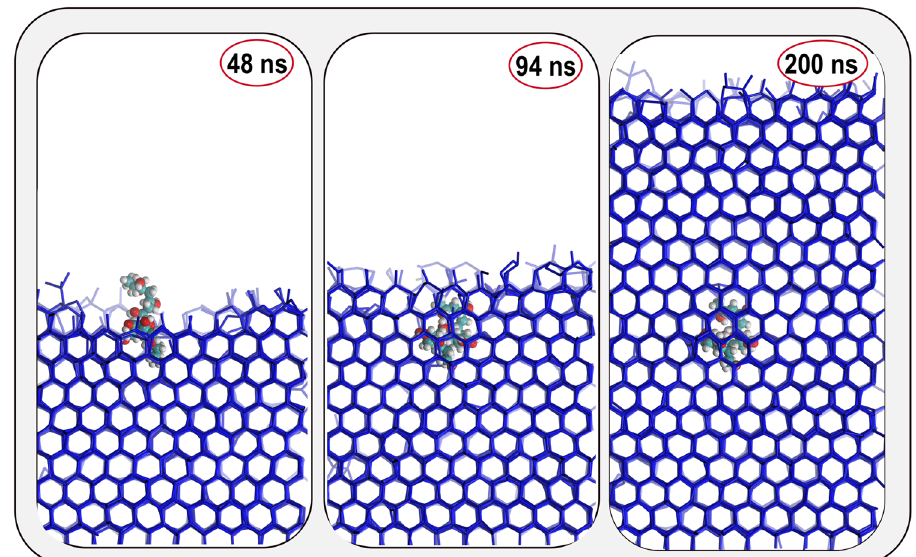
Fig. 4 PVA 10 does bind to ice. PVA 10 can bind to ice, independently of its conformation: however, the ice front overgrows the polymer due to the low DP of the latter, thus resulting in a lower IRI activity compared to e.g. PVA 20 . Only water molecules belonging to the ice phase are shown.